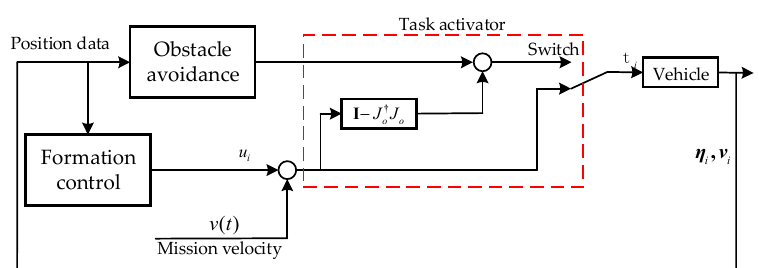
Figure 6. Two parts before or after obstacle avoidance.